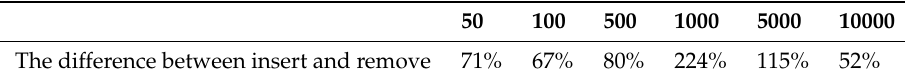
Table 5. The max and min execution time difference